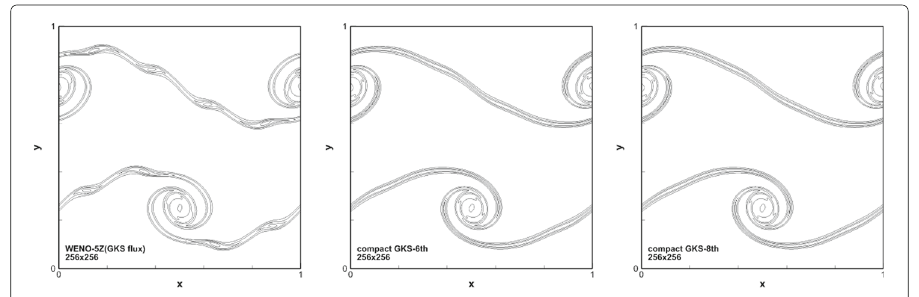
Fig. 22 Double shear flow: vorticity contours at t = 0.8, obtained by non-compact nonlinear reconstruction-based WENO-5th(GKS flux), and the 6th-order and 8th-order compact GKS with 256 × 256 mesh points